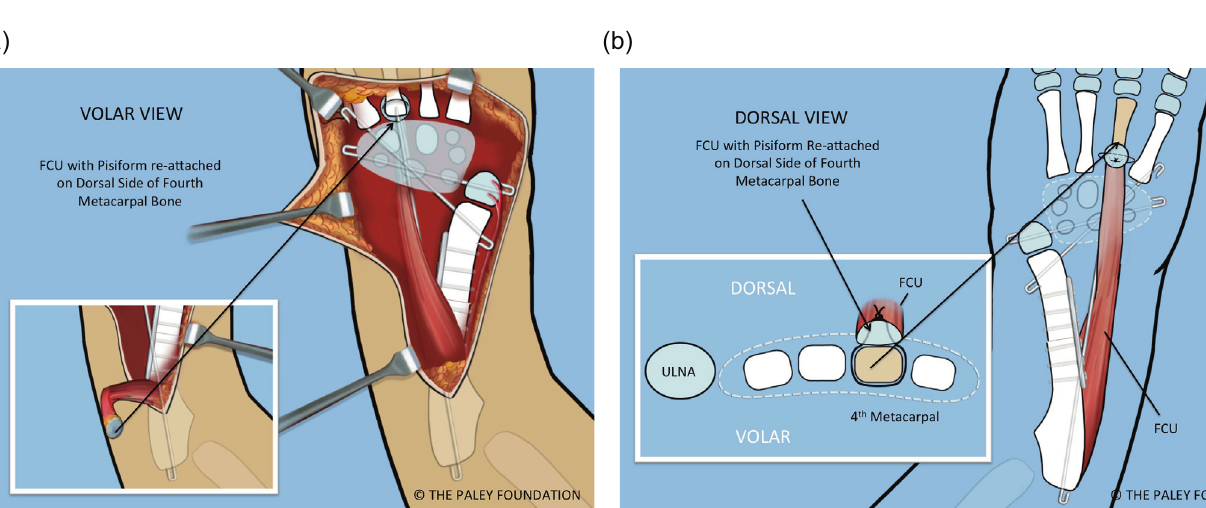
Figure 23. The FCU should be transferred to the dorsum of the hand. This is shown from the volar (a) and dorsal (b) and cross-sectional views (b). The pisiform bone is sutured to the base of the 4th metacarpal. A non-absorbable suture is passed around the base of this metacarpal.